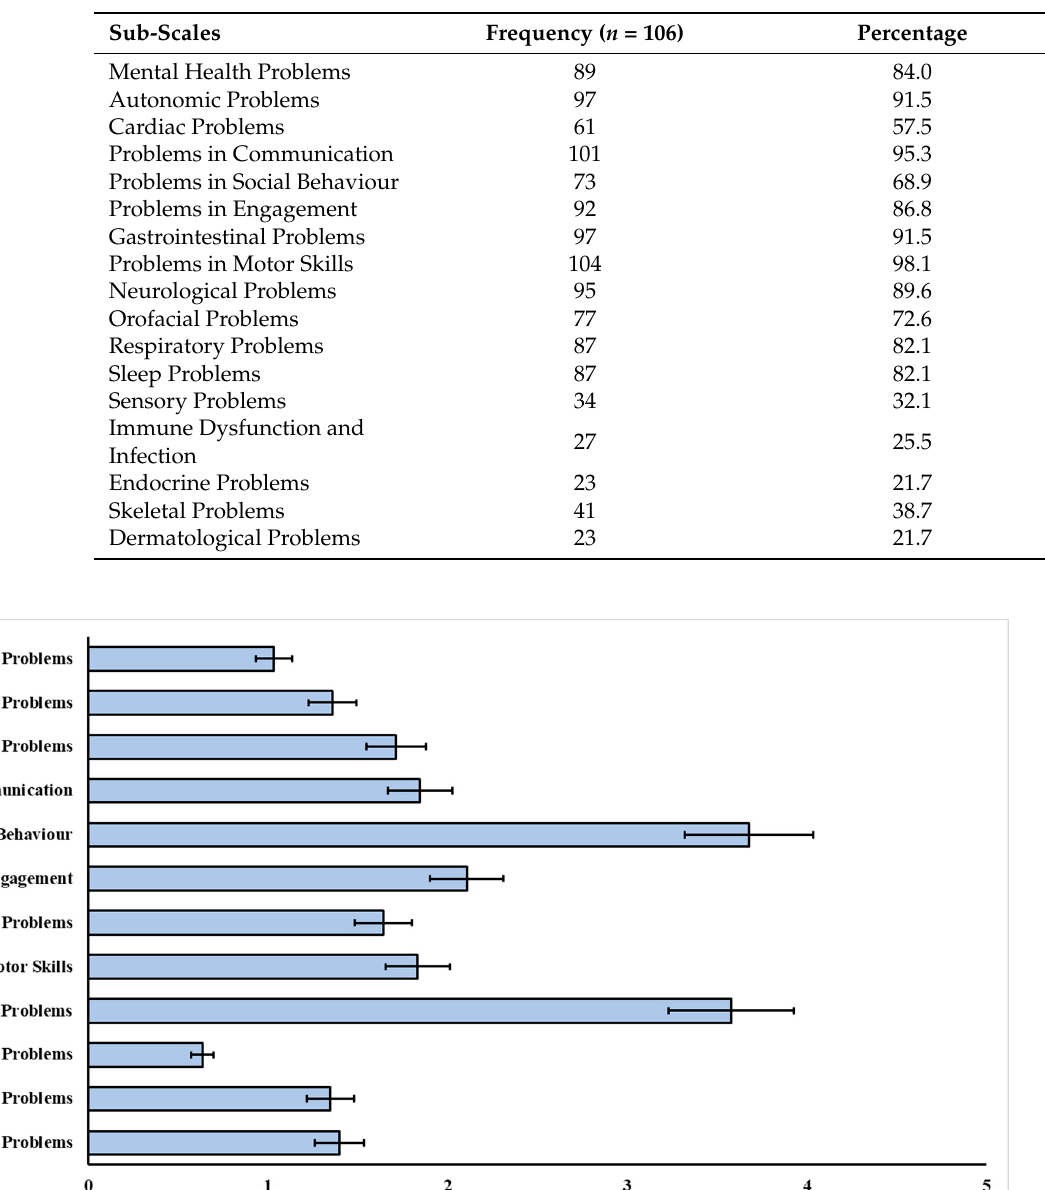
Table 3. Frequency and relative percentages of symptoms collected in Phase 2.